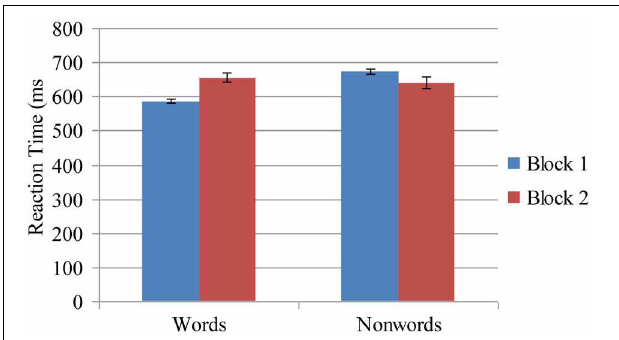
FIGURE 2 | Reaction time latencies measured in milliseconds as a function of lexical decision task word type (Words, Non-words) and as a function of block (Block 1, Block 2). Bars represent standard error.